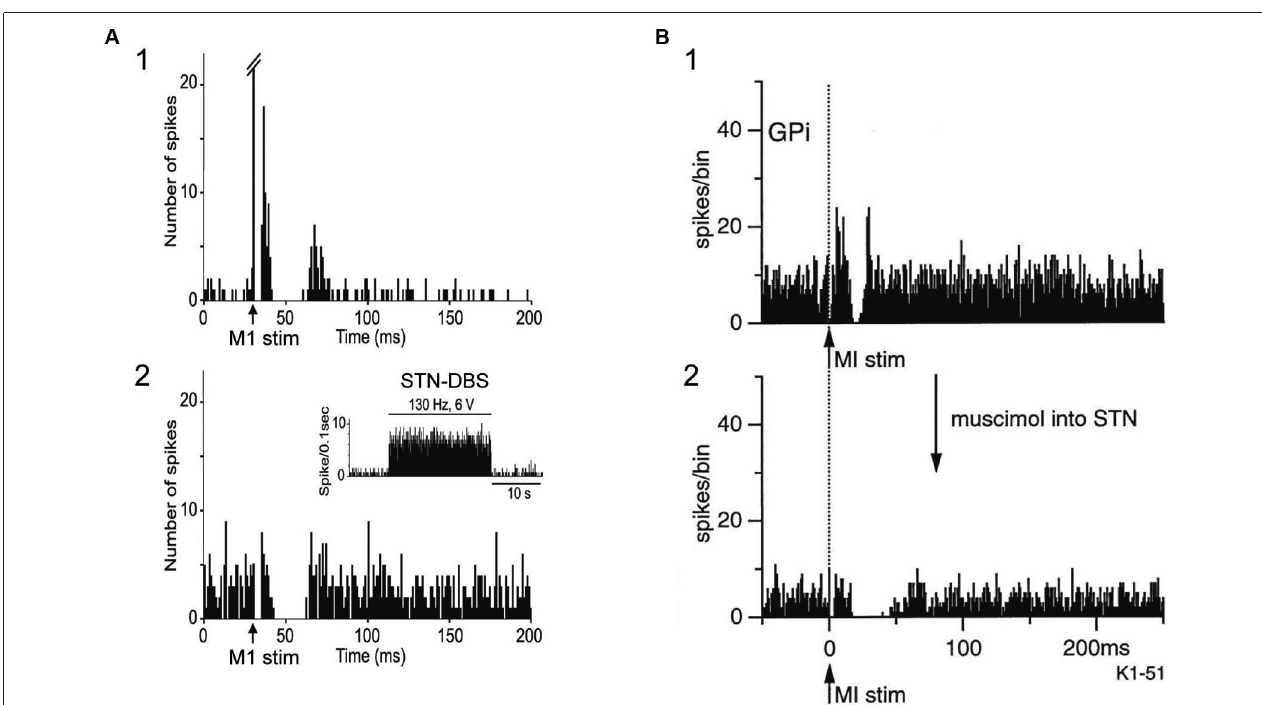
neuron in a normal monkey. PSTH (100 trials) in response to the single pulse stimulation of the Cx (arrow with dotted line) (1) and PSTH in response to Cx stimulation after blocking STN activity by muscimol (GABA A receptor agonist) injection into the STN (2) are shown. The cortically evoked early and late excitation was abolished after injection of muscimol into the STN, while cortically evoked inhibition was preserved. Modified from Nambu et al. (2000). Note that the pattern of cortically evoked responses of a SNr neuron during STN-DBS is similar to that of a GPi neuron after STN